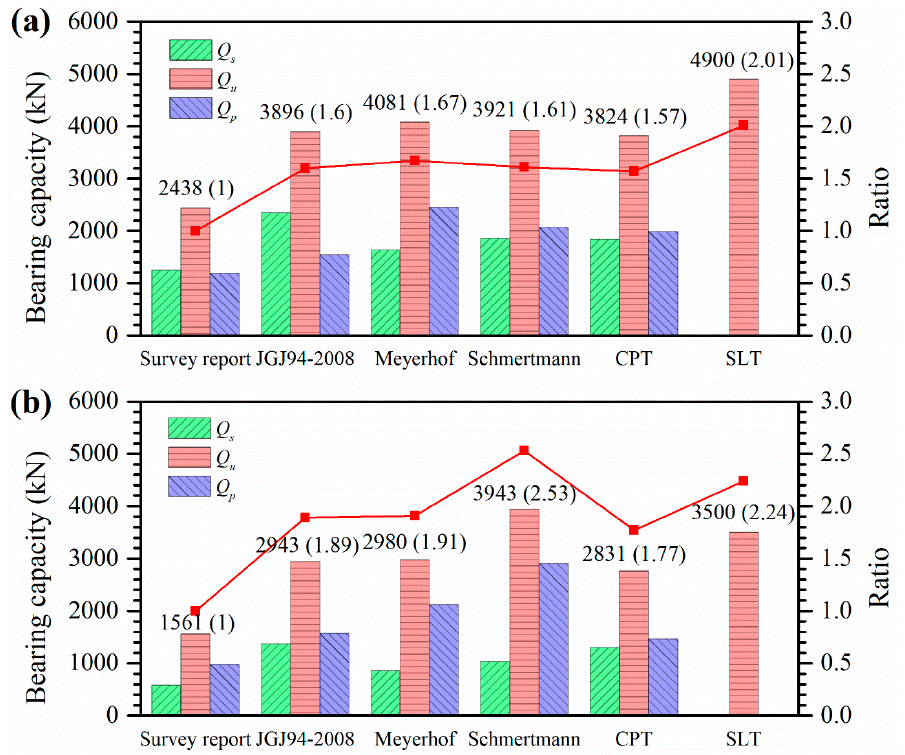
Figure 11. Comparison of bearing capacity. ( a ) Long piles (L = 21 m); ( b ) short piles (L = 12.5 m).